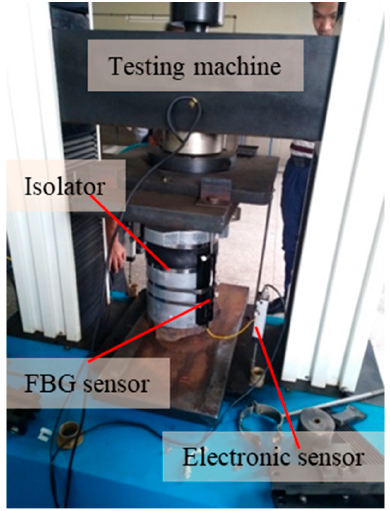
Figure 11. Static loading experiment of sensor.